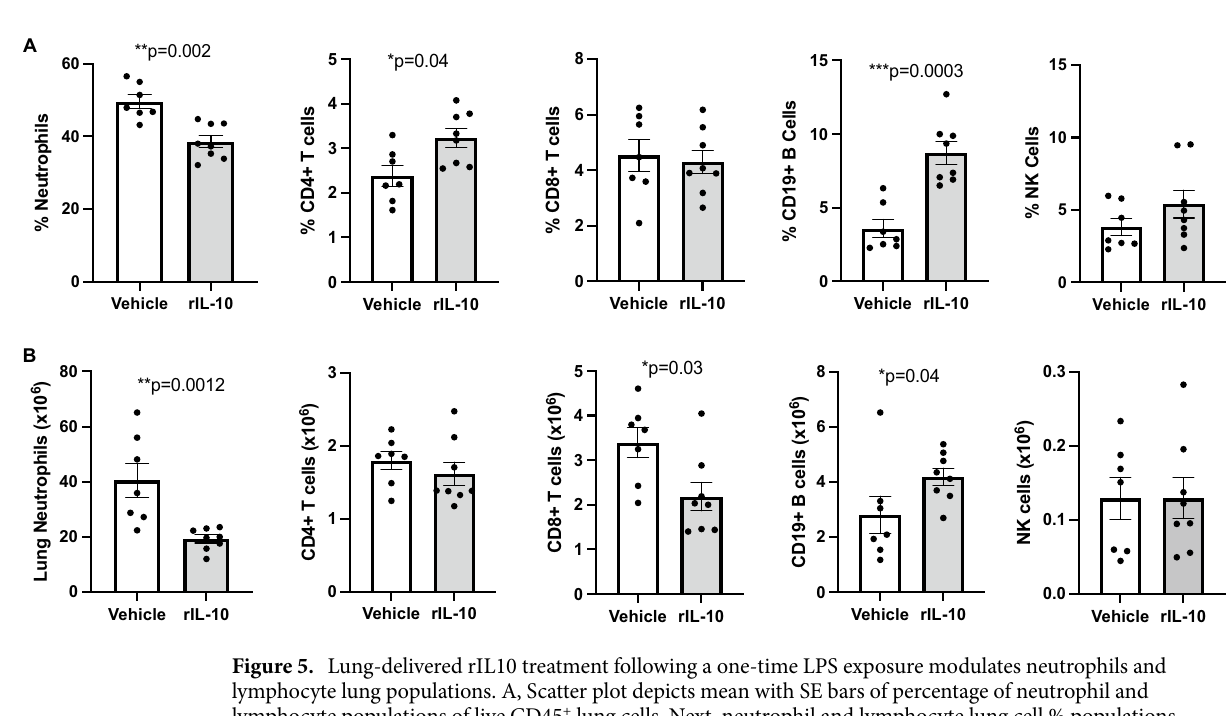
Figure 5. Lung-delivered rIL10 treatment following a one-time LPS exposure modulates neutrophils and lymphocyte lung populations. A, Scatter plot depicts mean with SE bars of percentage of neutrophil and lymphocyte populations of live CD45 + lung cells. Next, neutrophil and lymphocyte lung cell % populations multiplied by total lung cells ( B) . Gating strategy depicted in Supplemental Fig. 1. N = 7 (vehicle) and N = 8 (rIL-10) mice/group from 2 experimental runs. Statistical significance denoted by asterisks (*p < 0.05, **p < 0.01, ***p <